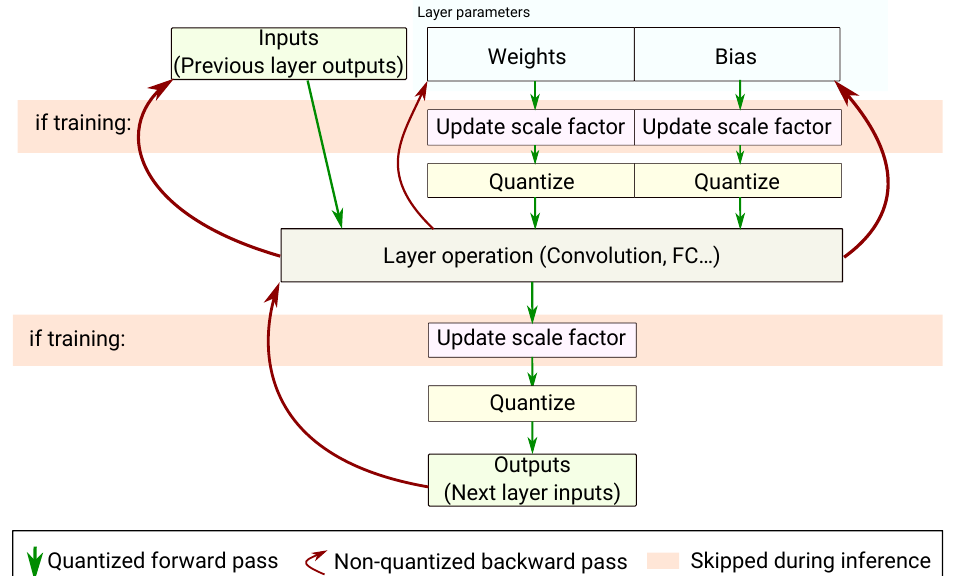
Figure 2. Quantization-Aware